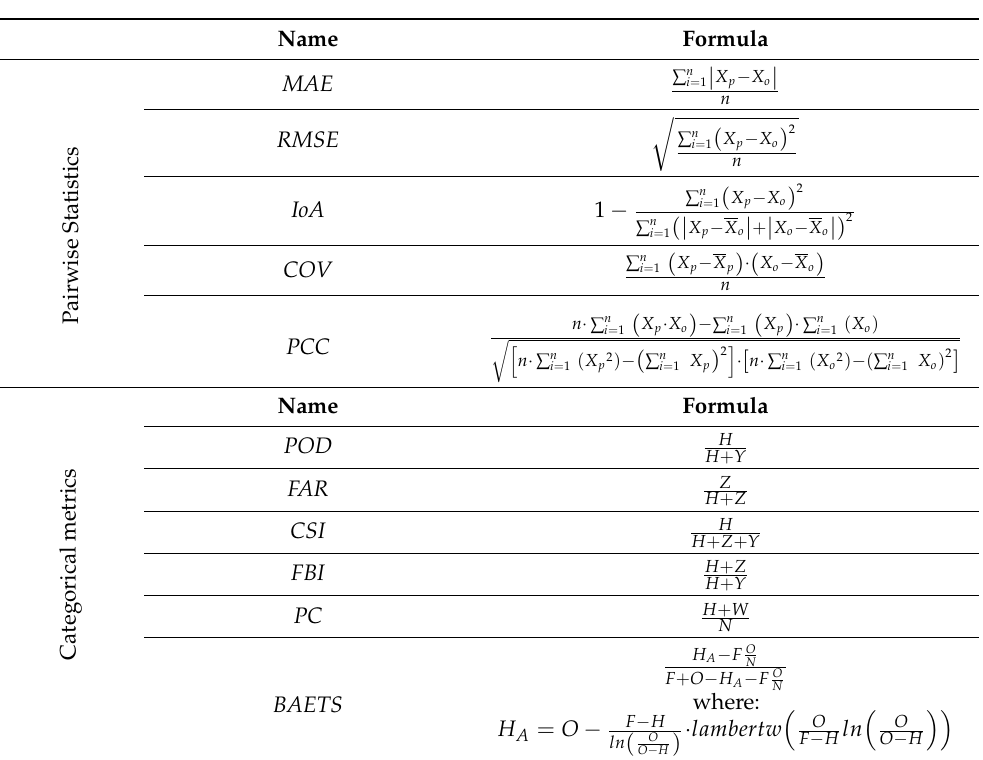
Table 3. Statistical